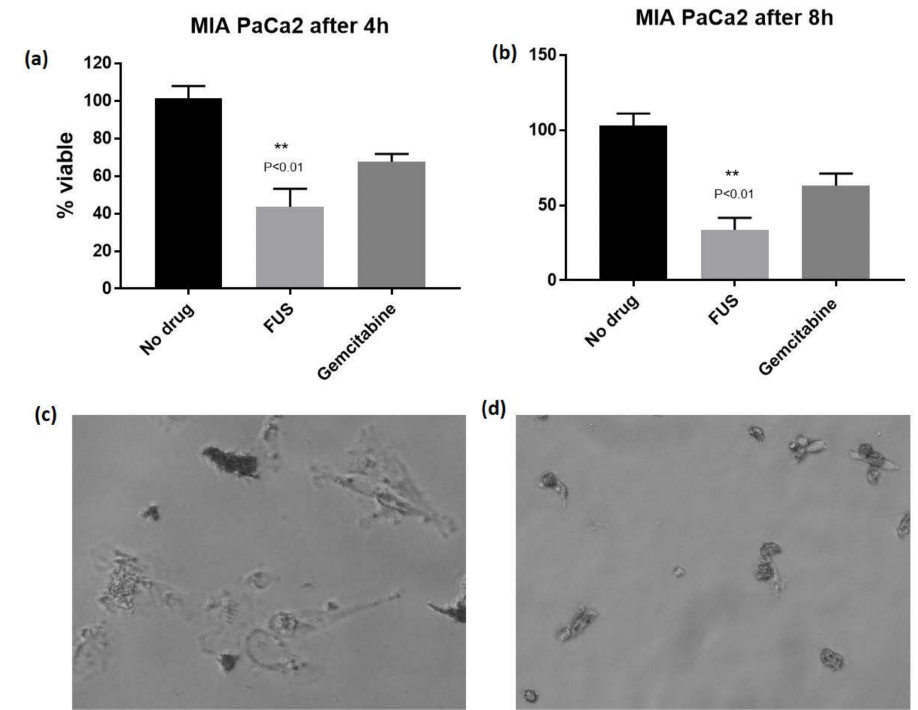
Figure 3. Effect of FUS on pancreatic cancer cell line. ( a , b ) FUS showed statistically significant rapid toxicity ( p < 0.01) against MIA PaCa2 cell line after 4 h and 8 h incubation; ( c , d ) morphological changes observed in MIA PaCa2 cell lines after 4 h and 8 h incubation,